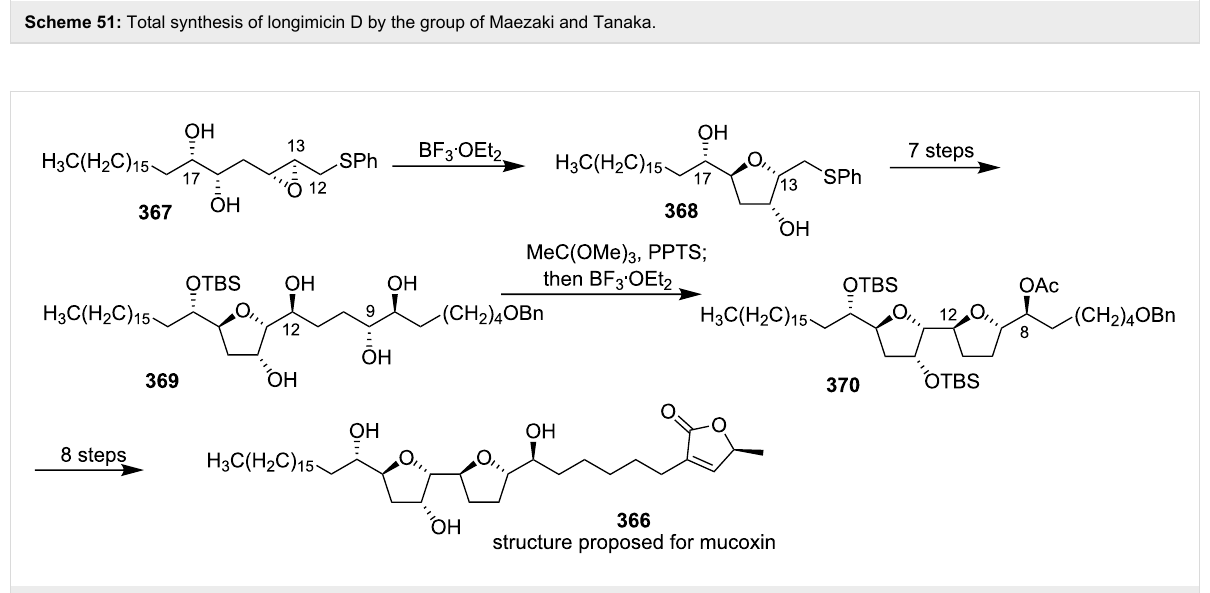
Scheme 52: Total synthesis of the structure proposed for mucoxin by Borhan’s